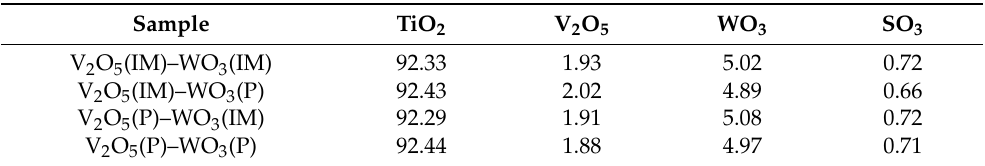
Table 1. X-ray fluorescence analysis of V 2 O 5 (IM)–WO 3 (IM), V 2 O 5 (IM)–WO 3 (P), V 2 O 5 (P)–WO 3 (IM), and V 2 O 5 (P)–WO 3